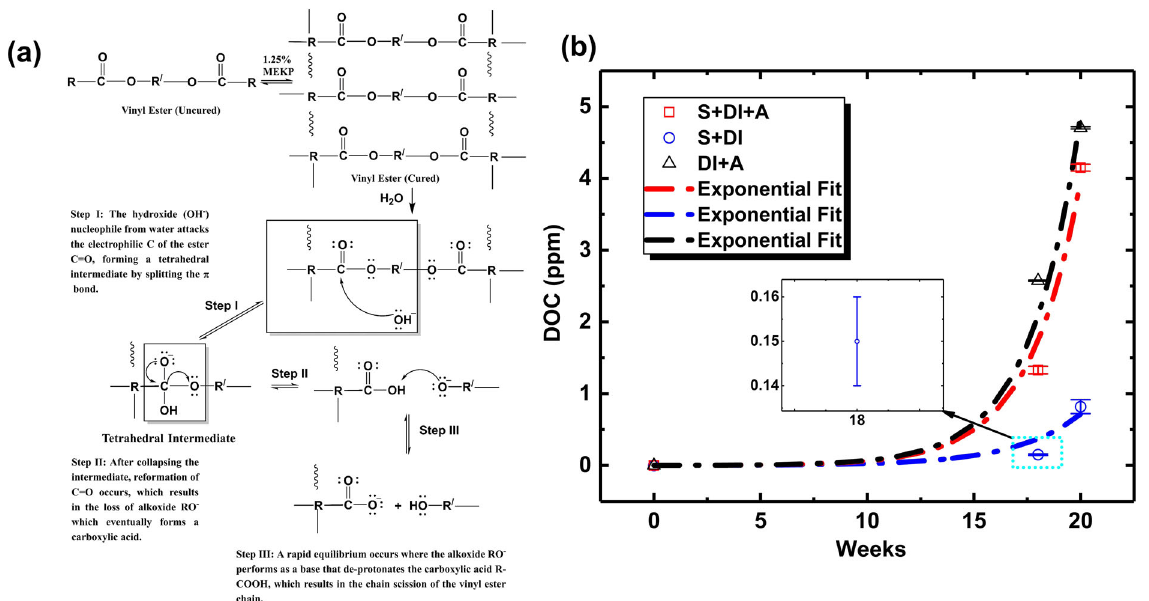
Fig. 8 Chemical structural alteration of vinyl ester resin after exposing to different conditions at different exposure due to polymer chain scission. a Mechanism explained — hydrolysis process of carbonyl group causes chain scission of esters, which results in dissolved organic carbon (DOC) content in the solution, b change in the DOC content (Supplementary Data 3 Table 18) (exponential fi t) for different conditions: autoclaved soil solution with deionized water ( □ − S + DI + A), soil solution with deionized water (O-S + DI), and autoclaved deionized water ( Δ - DI + A). Error bars indicate standard